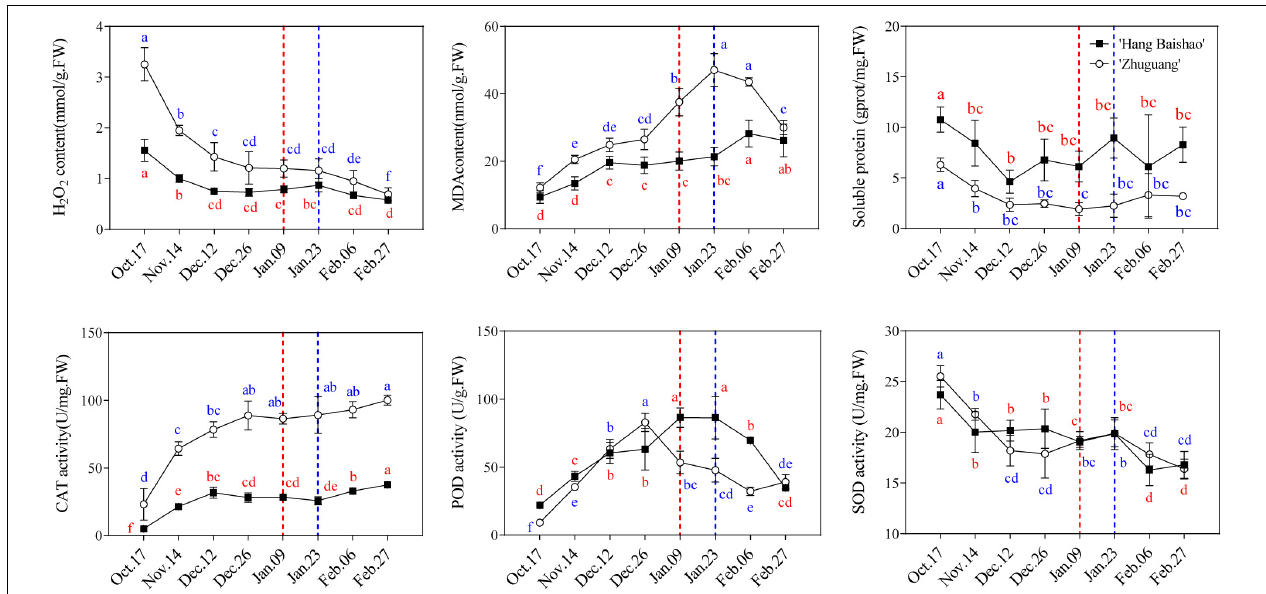
FIGURE 6 | Effect of natural chilling on oxidative stress related physiological and biochemical indices in ‘Hang Baishao’ and ‘Zhuguang’ during bud dormancy. Dashed red line indicates the bud endodormancy release date of low CR ‘Hang Baishao’ and dashed blue line indicates the bud endodormancy release date of high-CR ‘Zhuguang.’ Error bars represent standard deviation from three biological replicates and different letters indicate significant differences ( P < 0.05). Differences were compared among different move dates for each cultivar.